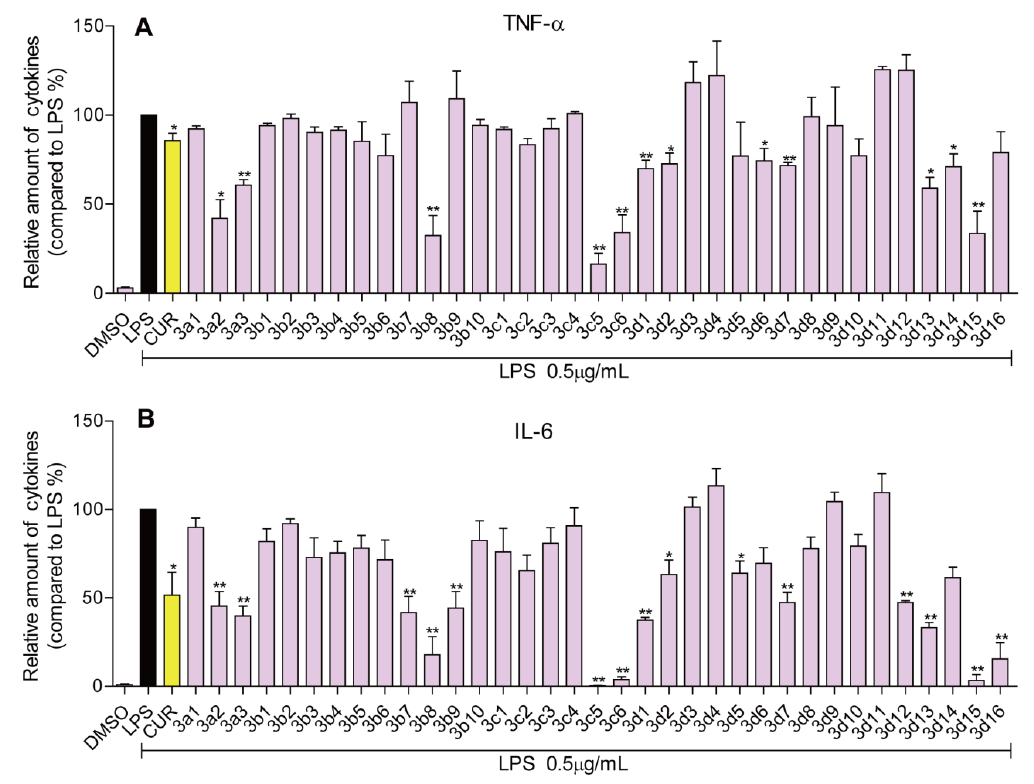
Figure 1. Effects of curcumin and its analogues on TNF- α ( A ) and IL-6 ( B ) production. Macrophages were pre-treated with vehicles, curcumin or its analogues (10 μ M) for 2 h, and then treated with or without LPS (0.5 μ g/mL) for 22 h. TNF- α and IL-6 levels in the culture media were measured by ELISA and were normalized by the total protein. Values represent the mean ± SEM for three independent experiments and LPS is regarded